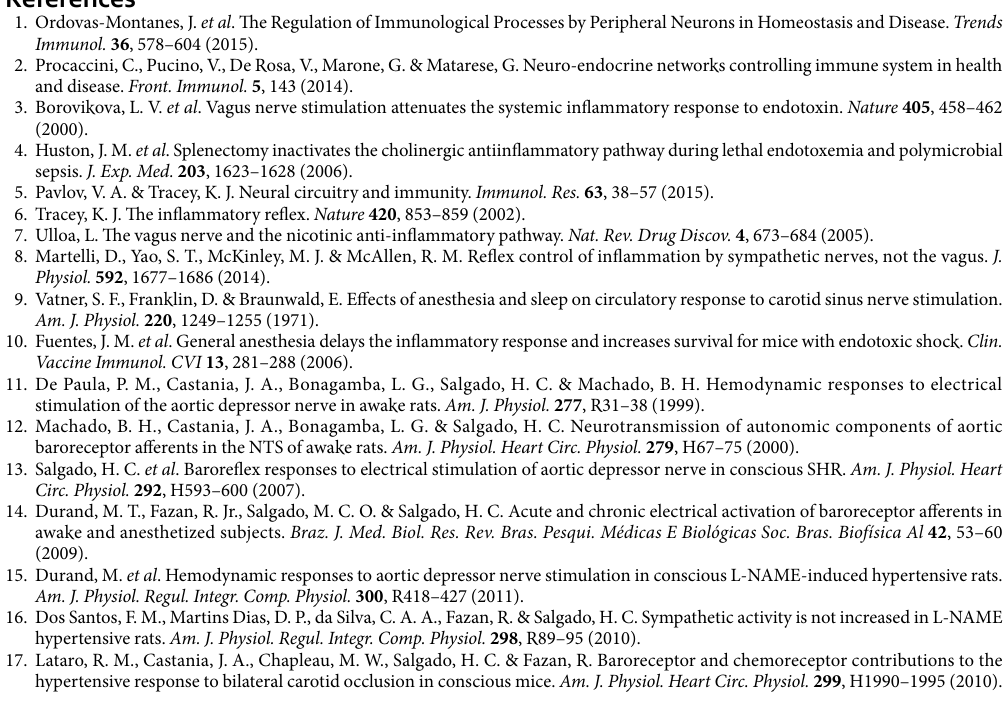
Statistical analysis. The results are shown as mean ± S.E.M. (standard error of the mean). Data were com- pared using one-way analysis of variance (ANOVA) followed by the Newman-Keuls post hoc test, and Student’s t -test. Differences were considered significant when p < 0.05 . All statistical tests were performed with SigmaStat 3.5 software (Systat Software Inc., San Jose, CA, USA).